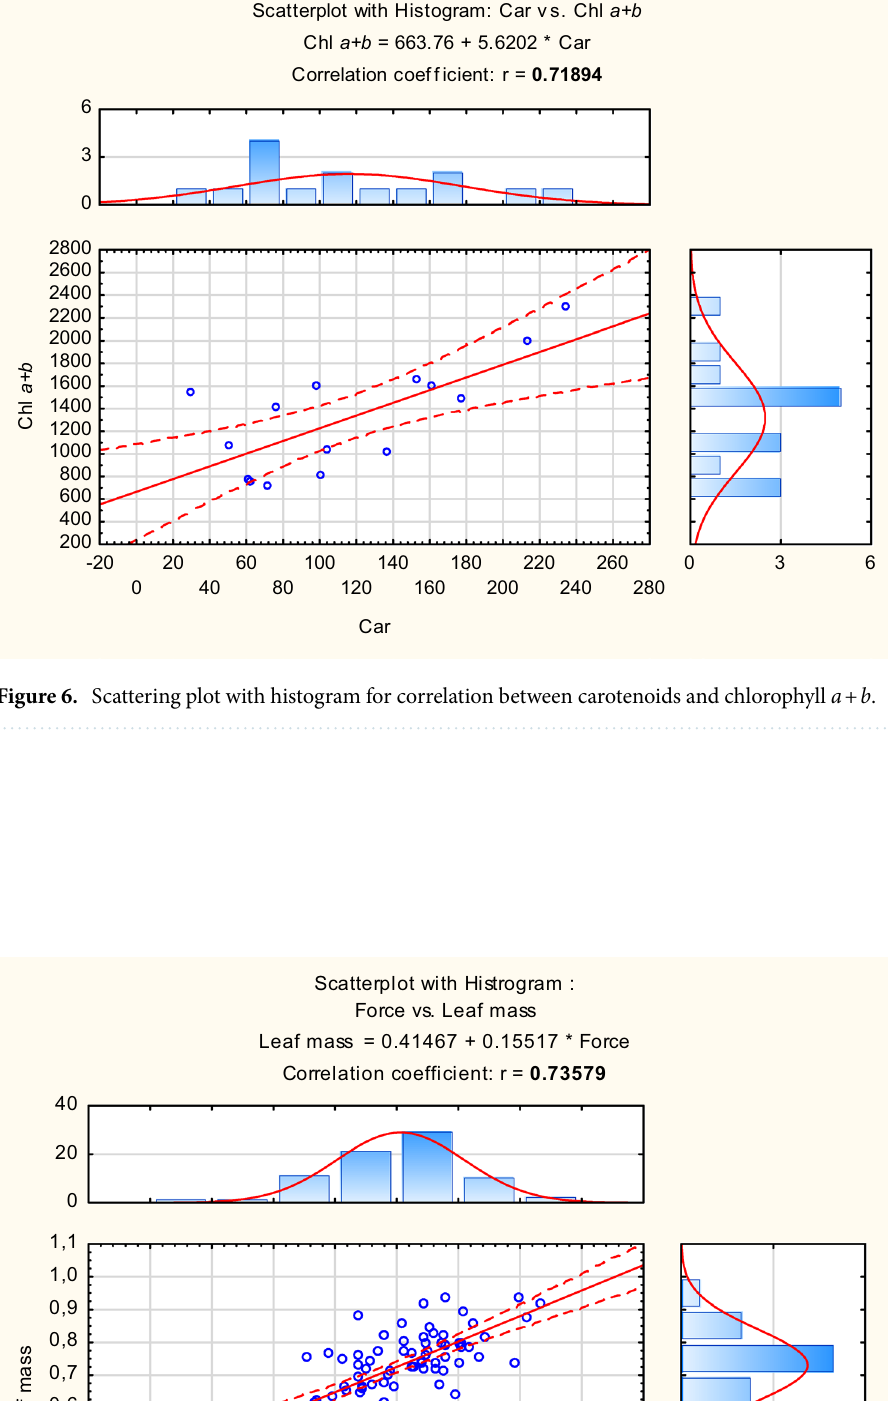
Figure 7. Scattering plot with histogram for correlation between disruptive force and leaf